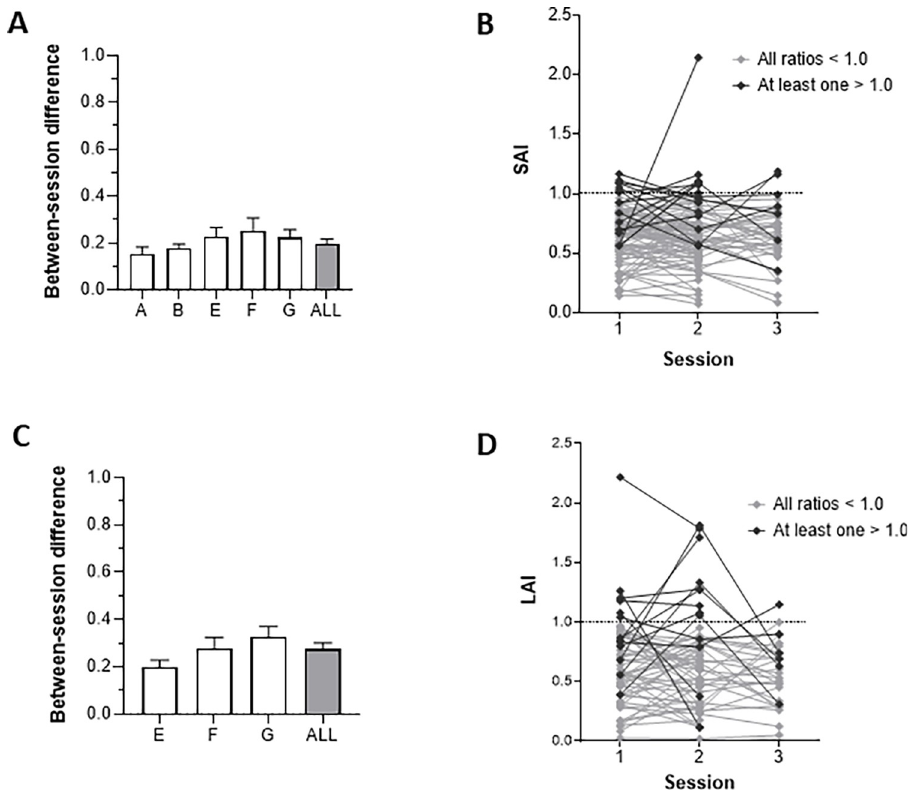
Fig 4. Reproducibility of SAI and LAI. The absolute size of between-session differences for studies with repeated baseline measures are shown on the left and individual SAI and LAI values are shown on the right. Between-session differences in SAI for each study (A; n = 92) are represented in the open bars while the average across all included studies is shown by the gray bar. Individual SAI data from the same studies is presented in B. Subjects who exhibited at least one SAI value > 1 are highlighted in dark gray while the rest are shown in light gray. Between-session differences in LAI for each study (C; n = 62) are represented in the open bars while the average across all studies is shown by the gray bar. Individual LAI data from the same studies is presented in D. All error bars reflect standard error of the mean.